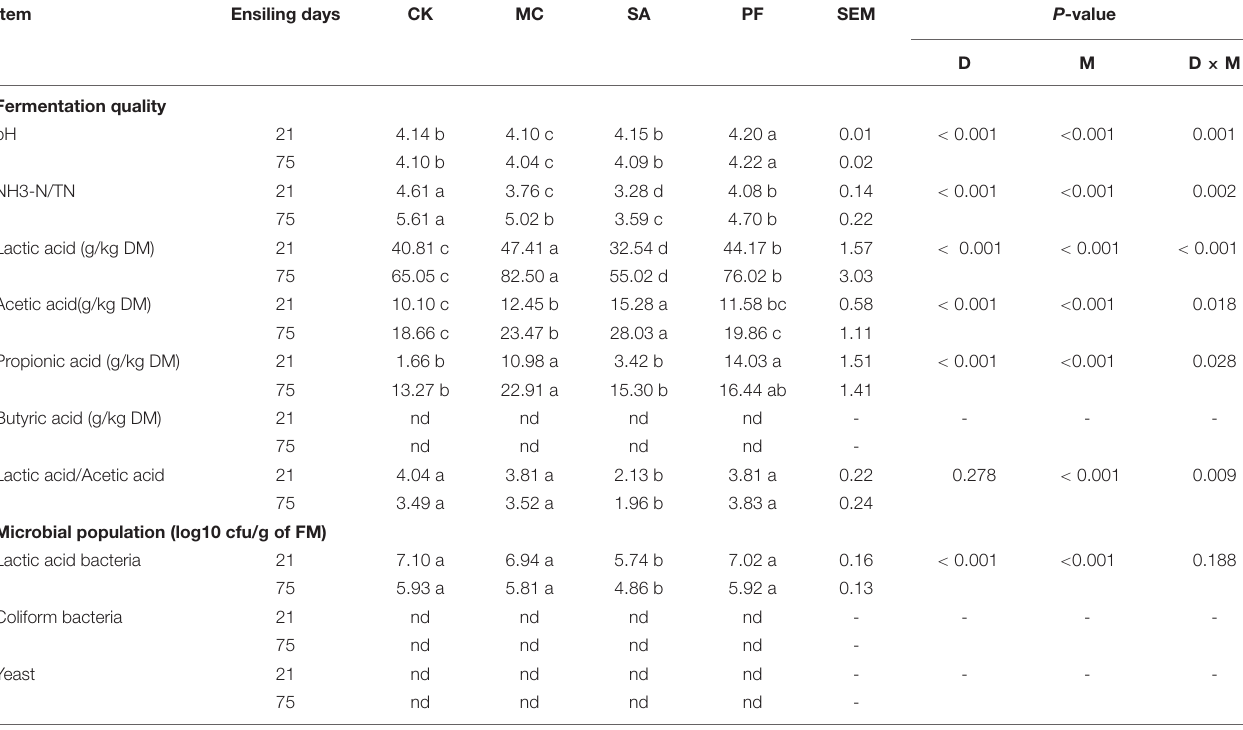
TABLE 2 | Fermentation characteristics of paper mulberry silage after 21 and 75 days of ensiling. Item Ensiling